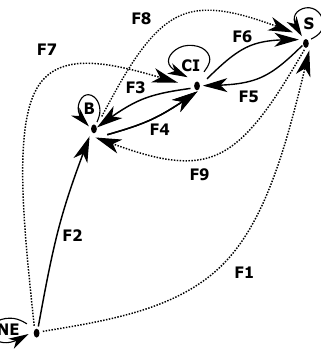
Figure 2. Human life as a mathematical category of